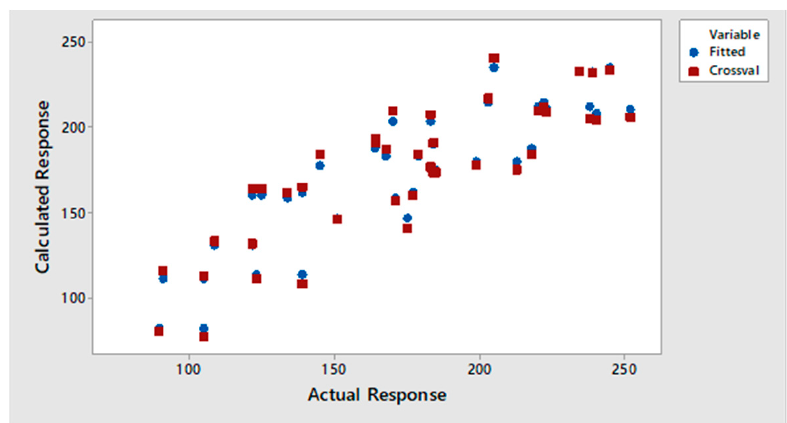
Figure 2. PLS model selection plot—q u max .